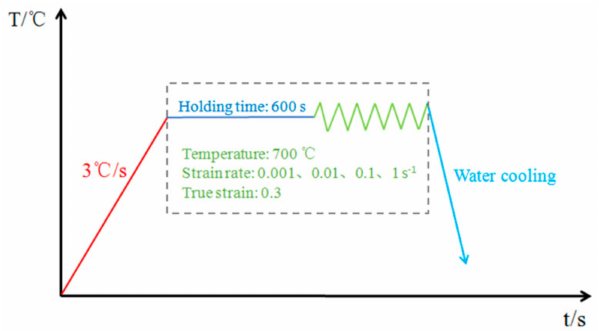
Figure 1. Schematic diagram of the hot compression test in this work.